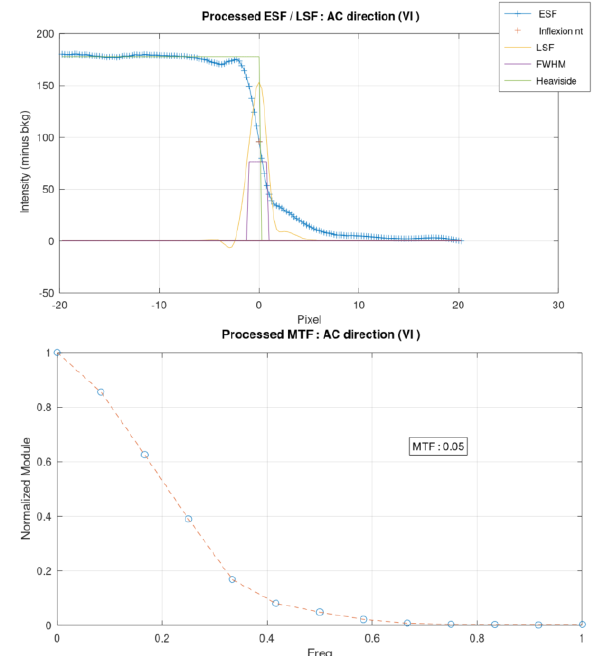
Figure 6. The ESF, LSF, FWHM, SNR, RER and MTF results over the Vl direction (across-track) from the pan band in Salon- de-Provence.